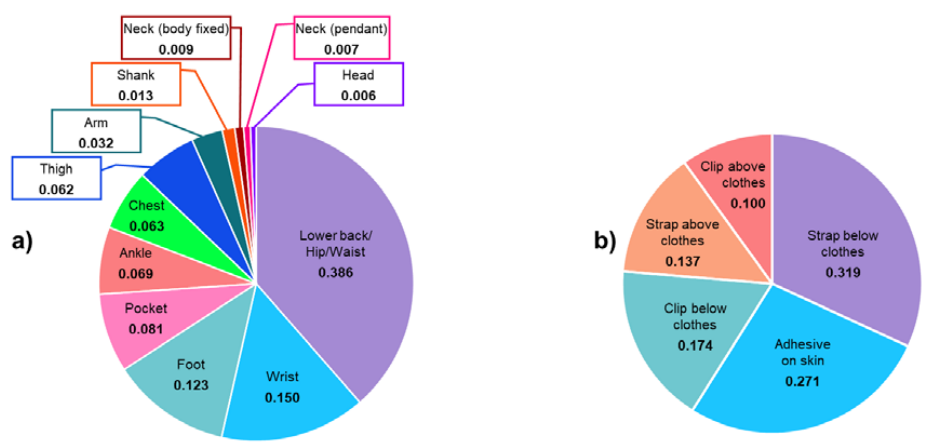
Figure 6. Scores for the different identified device locations ( a ) and fixation modality ( b ). Values were obtained based on the best three choices expressed from each participant and their relevant LoE .